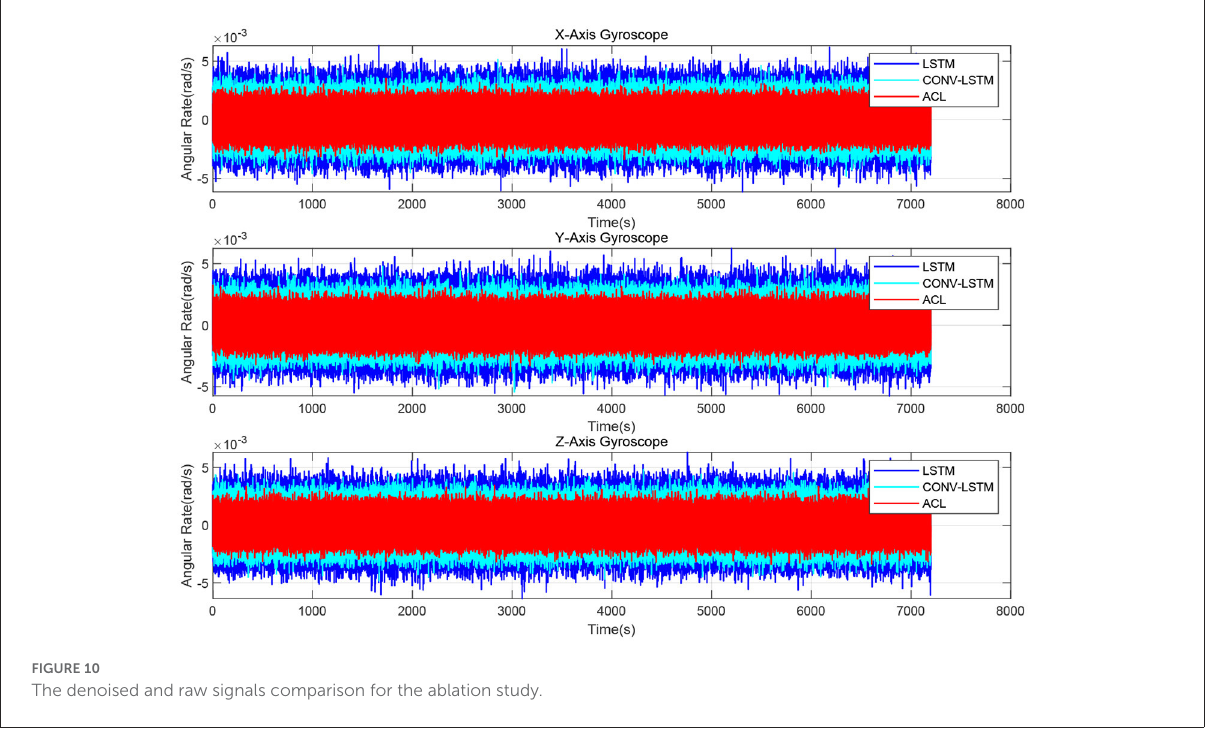
FIGURE10 The denoised and raw signals comparison for the ablation study.